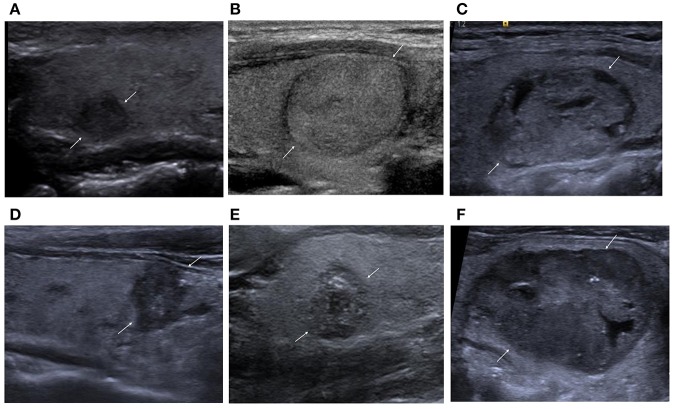
(A) Nodular goiter. Solid and hypoechoic nodule. ACR-TIRADS, 4; EU-TIRADS, 4; Kwak-TIRADS, 4B; ATA classification, high suspicion. (B) Follicular adenoma. Solid and isoechoic nodule. ACR-TIRADS, 3; EU-TIRADS, 3; Kwak-TIRADS, 4A; ATA classification, low suspicion. (C) Follicular adenoma. Mixed cystic and solid. ACR-TIRADS, 3; EU-TIRADS, 3; Kwak-TIRADS, 3; ATA classification, low suspicion. (D) Papillary thyroid carcinoma. Solid and hypoechoic nodule with taller-than-wide shape, irregular margins, and microcalcification. ACR-TIRADS, 5; EU-TIRADS, 5; Kwak-TIRADS, 4C; ATA classification, high suspicion. (E) Papillary thyroid carcinoma. Solid and hypoechoic nodule with microcalcification and macrocalcification. ACR-TIRADS, 5; EU-TIRADS, 5; Kwak-TIRADS, 4C; ATA classification, high suspicion. (F) Medullary thyroid carcinoma. Mostly solid and hypoechoic nodule with dispersed microcalcifications. ACR-TIRADS, 5; EU-TIRADS, 5; Kwak-TIRADS, 4C; ATA classification, high suspicion.